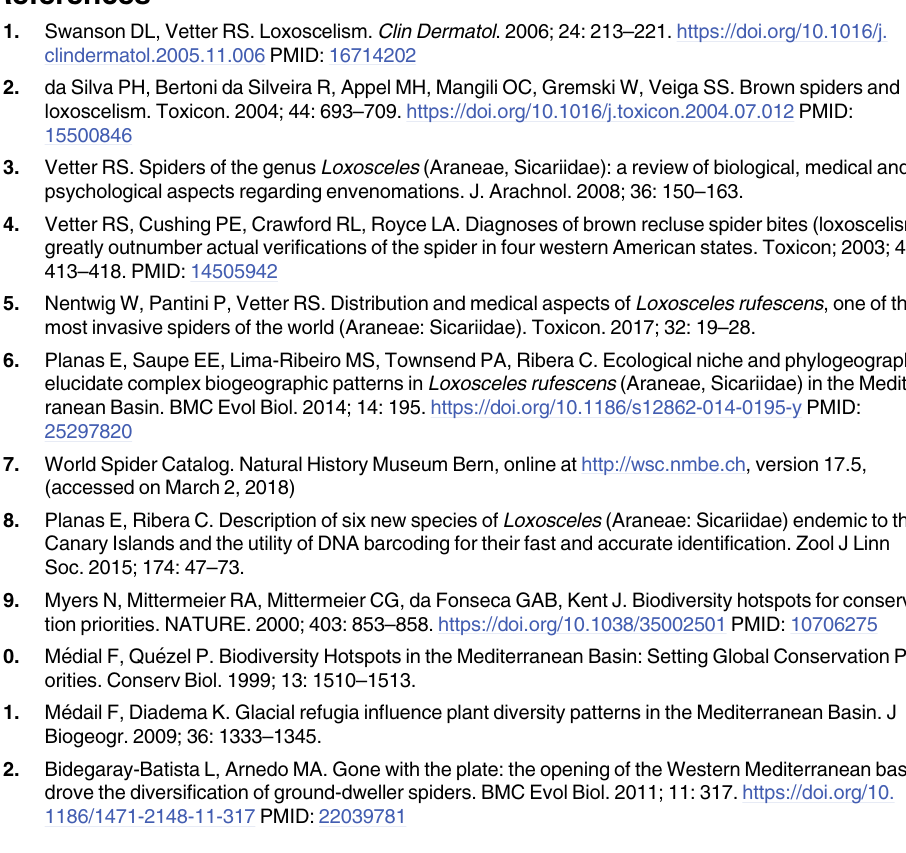
S4 Table. Number of individuals and missing data per